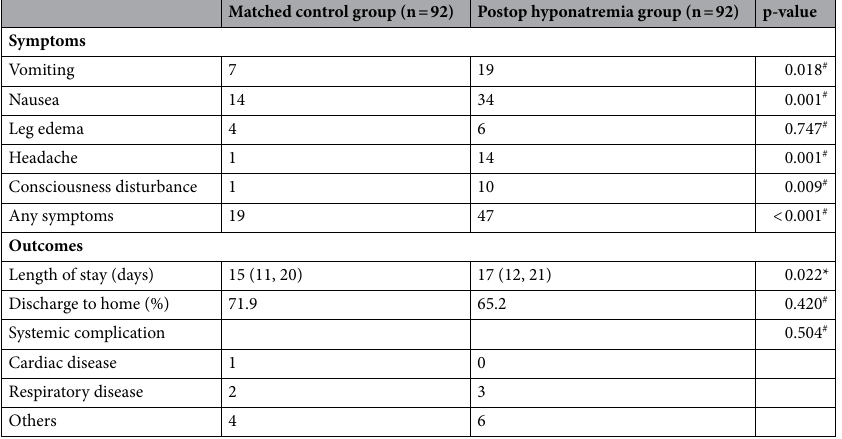
Table 5. Potential symptoms and outcomes of hyponatremia postoperatively. Continuous variables are represented by their median with 1st and 3rd quartiles. Postop postoperatively. *Mann–Whitney U test. # Chi- squared